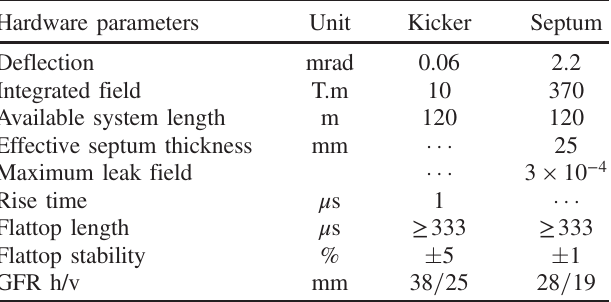
TABLE V. Parameters of kicker and septum at FCC extraction for the alternative concept.